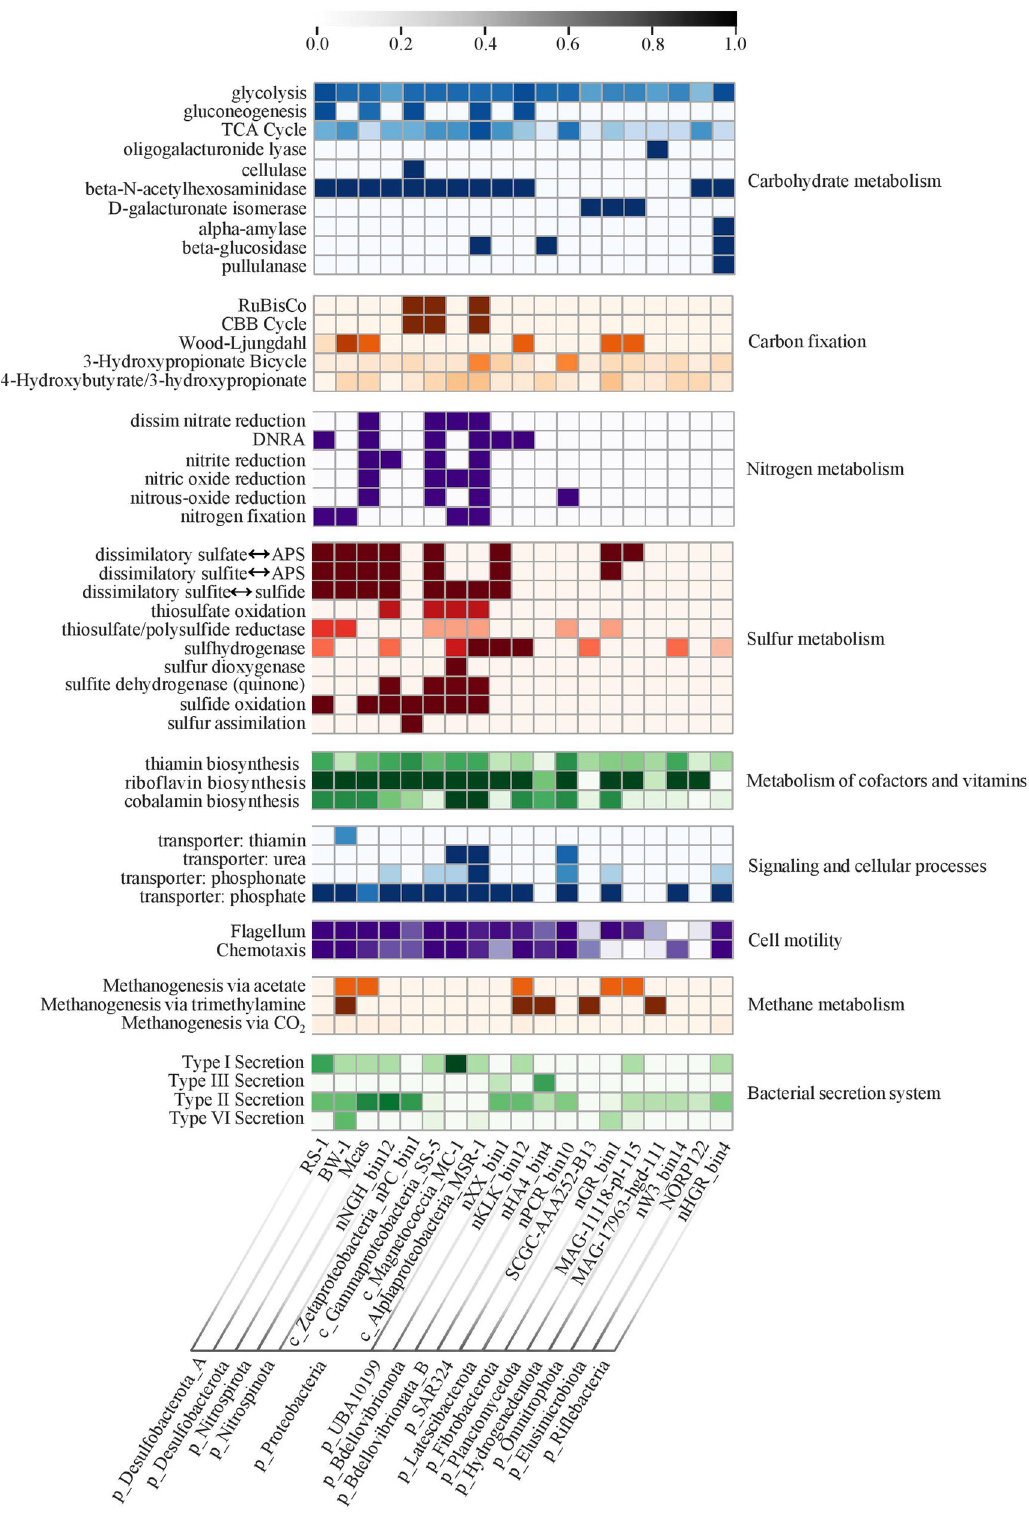
Fig. 5 Metabolic pathways of representative MTB genomes across 16 bacterial phylum-level lineages. The color gradient represents the completeness of major metabolic pathways inferred from the presence or absence of genes. Dark represents a complete or nearly complete pathway, and white represents a pathway that is absent or mainly incomplete. Note that most available MTB genomes are draft or incomplete, so we cannot rule out that the absence or incompleteness of metabolic pathways maybe due to the fragmented nature of draft genomes. All taxonomic groupings are based on the GTDB taxonomy (Release 89,